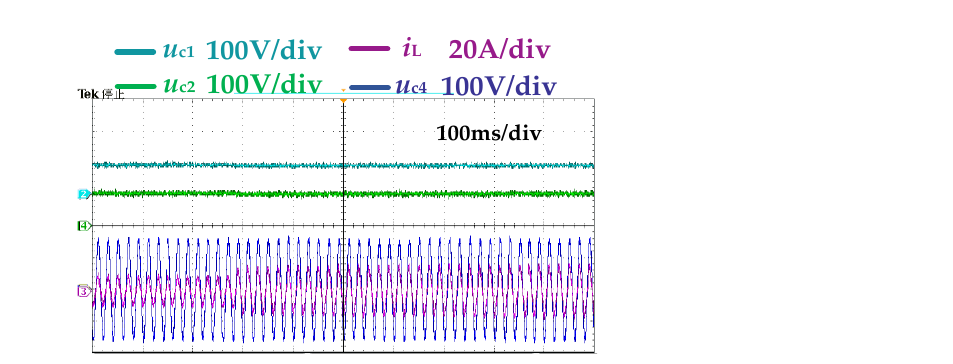
Figure 13. Experimental results of current i L and voltages u s , u dc and u ab .